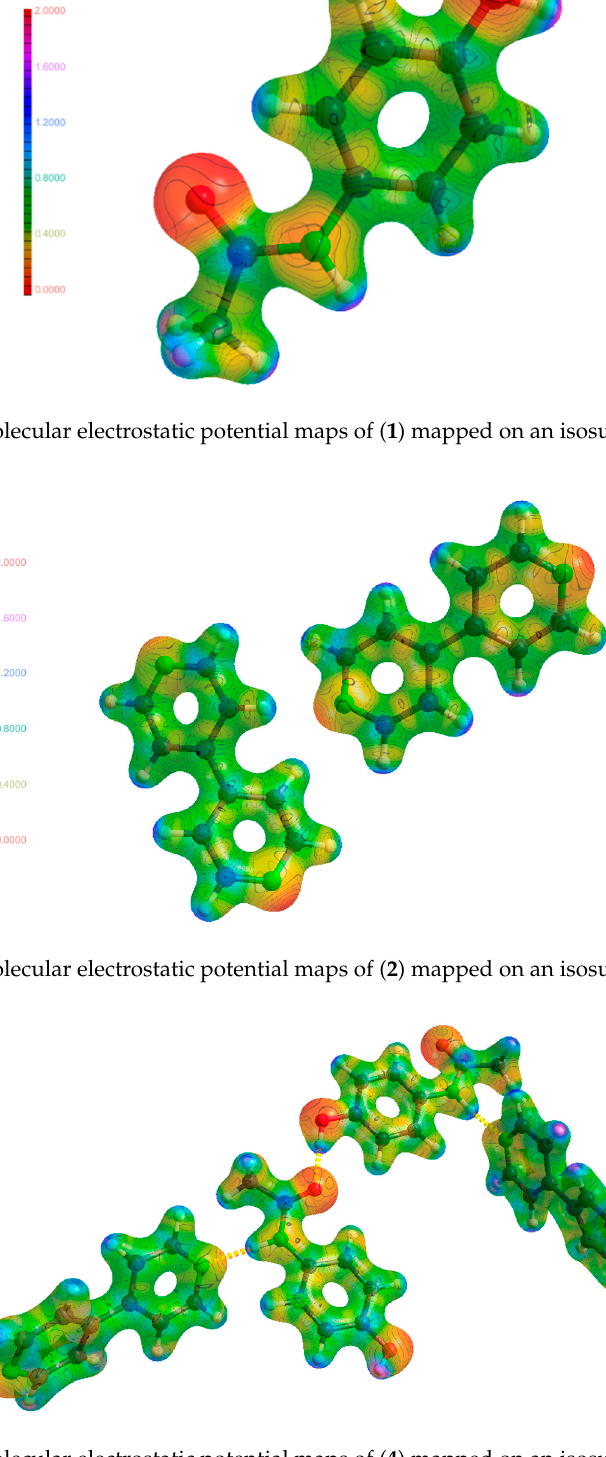
Figure 13 . Molecular electrostatic potential maps of ( 4 ) mapped on an isosurface of ρ .